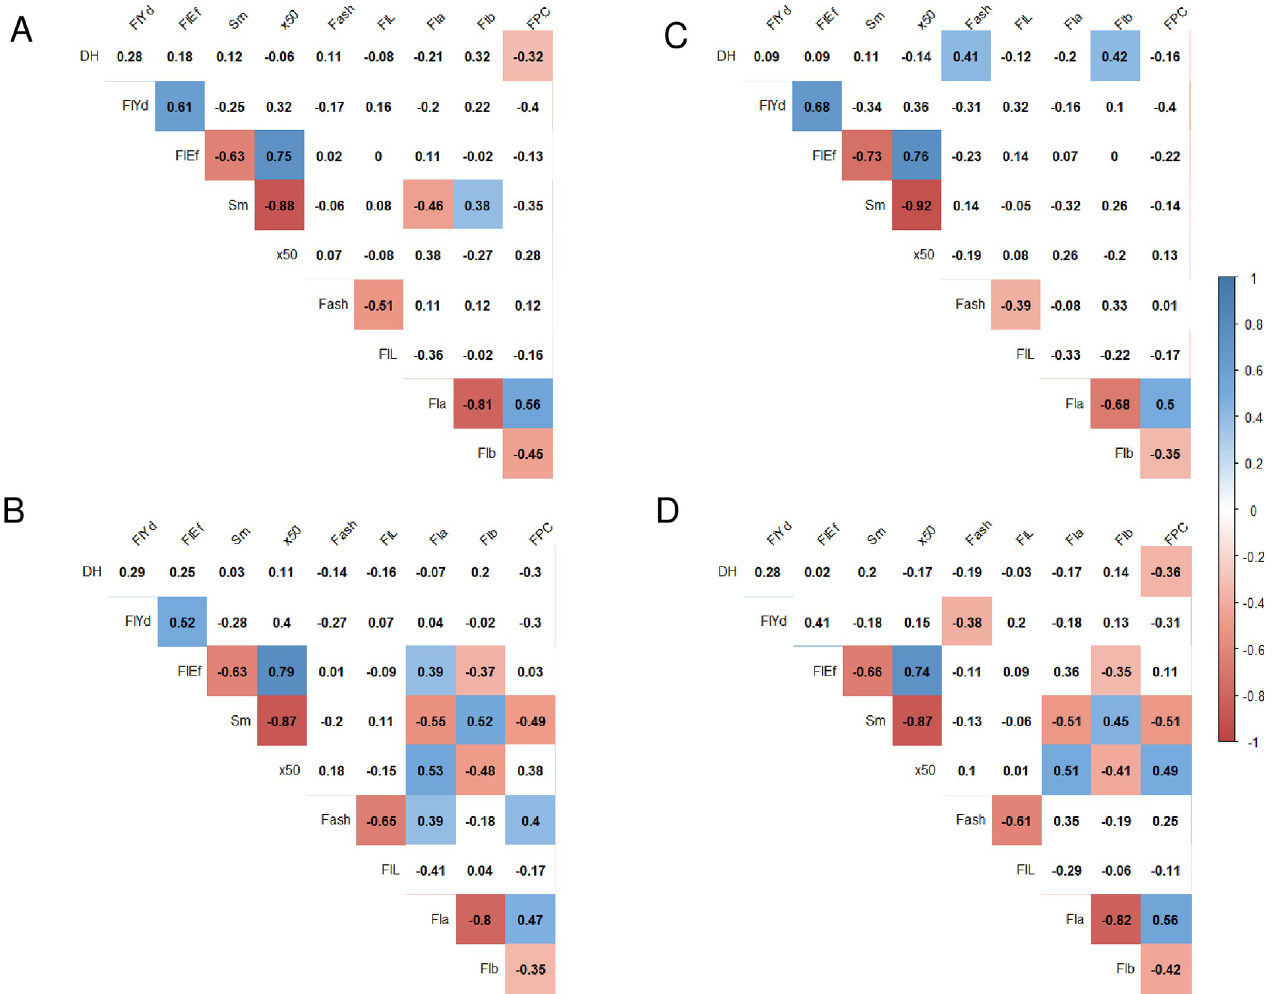
Fig 2. Correlation coefficients between ten traits for the three populations combined (A), Kinuhime/Kitahonami population (B), Shunyou/Kitahonami population (C) and Tohoku224/Kitahonami population (D). Colored boxes indicate that the correlation coefficients are significant at the 0.05 level. DH: days to heading from May 1st, FlYd: flour yield, FlEf: flour efficiency, Sm: specific area of flour particles, x50: median size of flour particles, Fsh: flour ash content, FlL: flour color L � , Fla: flour color a � , Flb: flour color b � , and FPC: flour protein